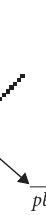
Figure 8: Angle variation